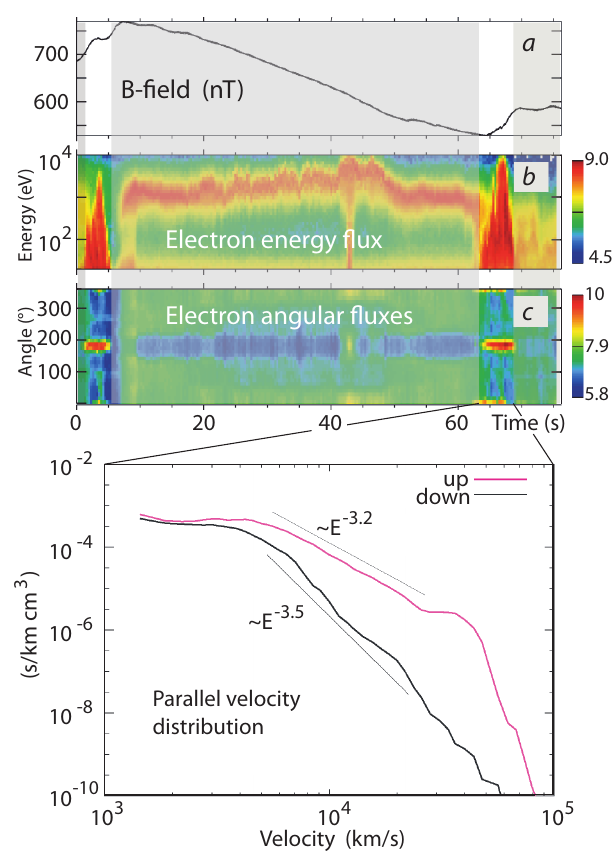
Fig. 1. The two narrow downward current regions of the FAST 1773 orbit flanking the shaded extended upward current region. (a) Mag- netic field with the two positive gradient regions indicating down- ward currents. (b) Electron energy flux. The downward current region is characterised by their typical broad electron energy fluxes. (c) Angular distribution of flux. Showing its concentration at an- gles of 180 ◦ . The parallel electron distribution is shown for the second region in the lower part of the figure (upward electron ve- locities are negative, here shown mirrored into positive speeds). The low energy flat part is caused by electric-field acceleration. Upward electron fluxes are substantially higher than downward and exhibit a sharp cut-off at high energies after a power law part, indicating strong upward acceleration. The difference between upward and downward fluxes is responsible for the downward current and cor- responds to a non-zero upward bulk velocity (Data obtained within the University of California Berkeley – France